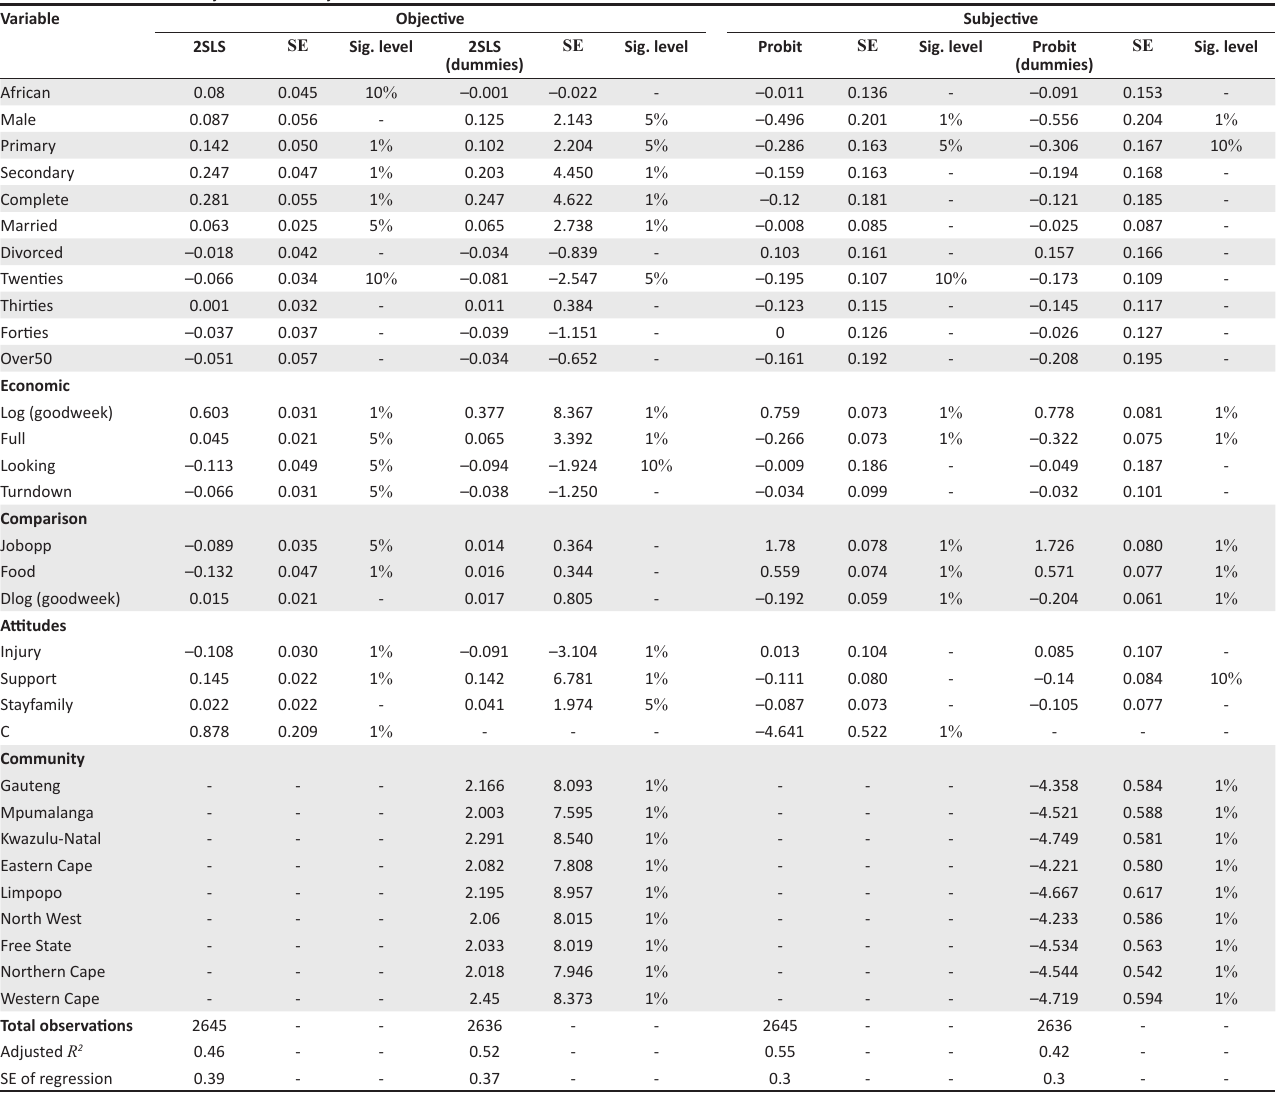
TABLE 12: Results for the objective and subjective functions.